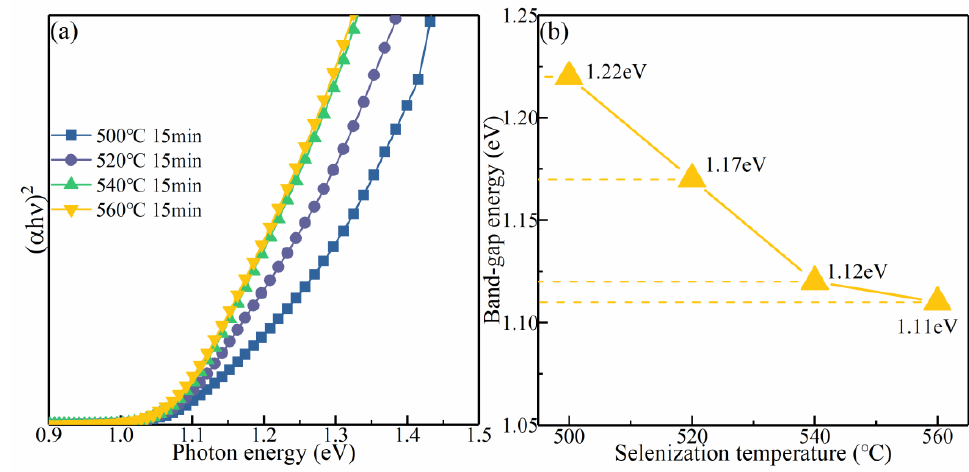
Figure 8. ( a ) The plot of (αhυ) 2 against hυ for CMZTSSe films annealed at 500 °C 520 °C, 540 °C, and 560 ◦ C; ( b ) The variation in bandgap for the CMZTSSe films as a function of the selenization temperature.